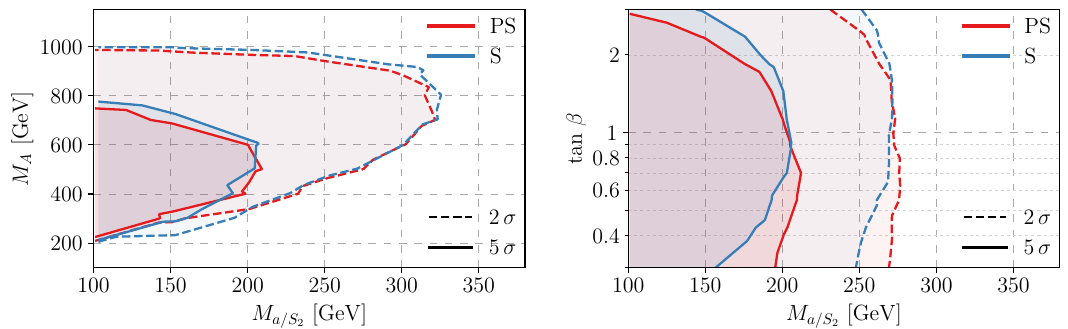
Figure 9 . 2 (cid:27) (dashed) and 5 (cid:27) (solid) exclusion limits from mono- Z searches in the M plane (left) and M {tan (cid:12) -plane (right) for the 2HDM+S (blue) and PS (red). In both plots we a=S 2 use the parameters as given in eq. (4.4) with tan (cid:12) = 1 for the left one and M A = 500 GeV for the right